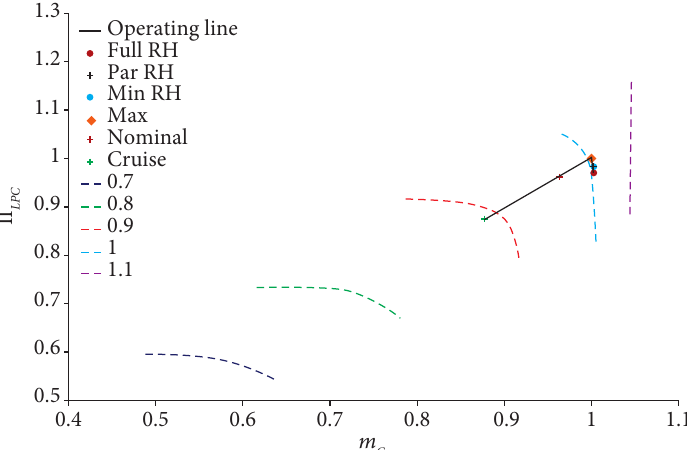
Figure 13. Characteristic maps with simulated operating line(shown in black). Also experimental operating points corresponding to different ratings are shown with